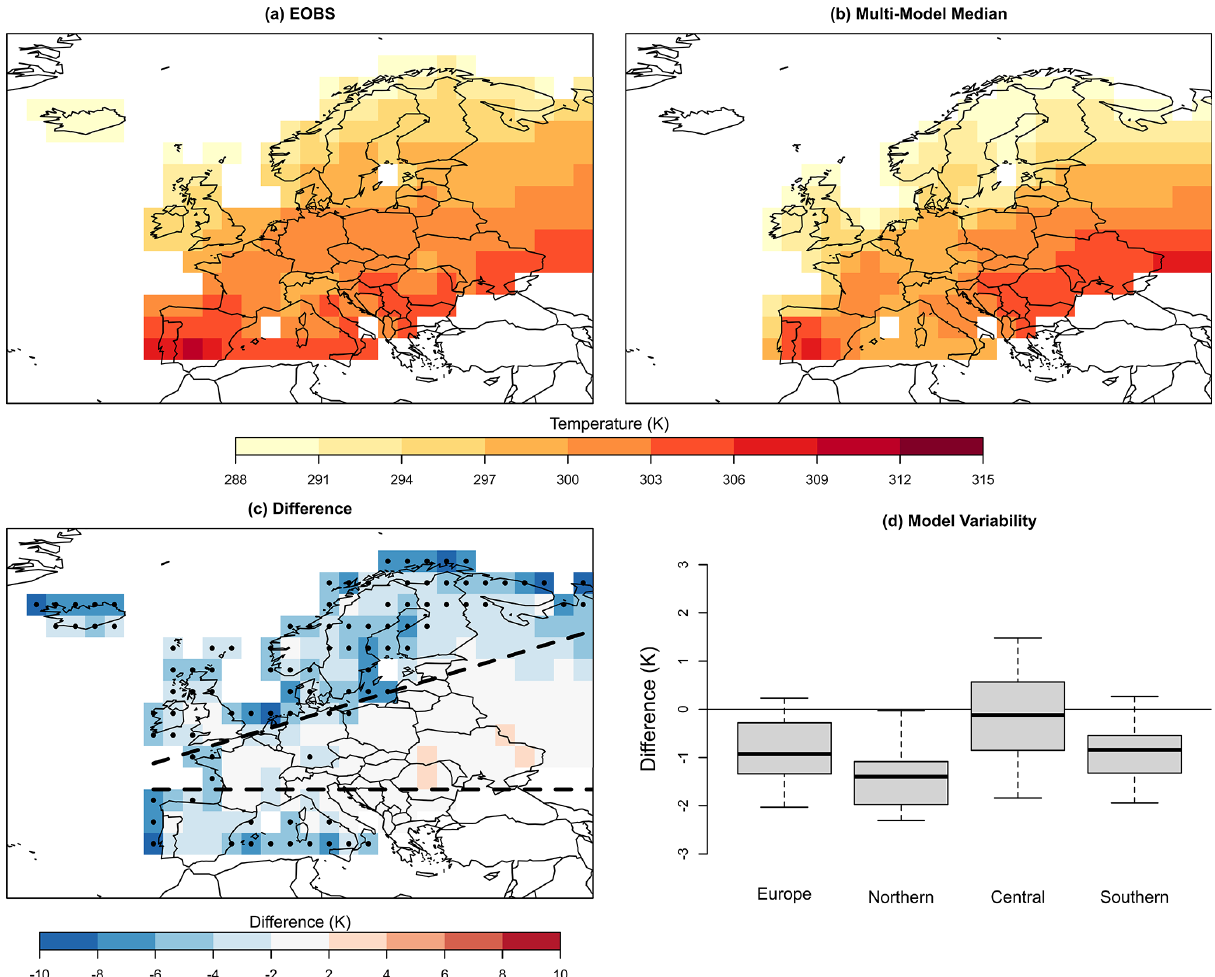
Figure 3. Mean maximum temperatures during dry spells longer than 5d (Tx DS ) in (a) EOBS and (b) the CMIP5 multi-model median. (c) Multi-model median difference between CMIP5 models and EOBS (stippling indicates where 90% of CMIP5 models are below or above EOBS). (d) The variability in the percentage difference across all models averaged across all grid cells in Europe, northern Europe, central Europe and southern Europe. The separation between the three European regions is shown by the dashed lines in (c)